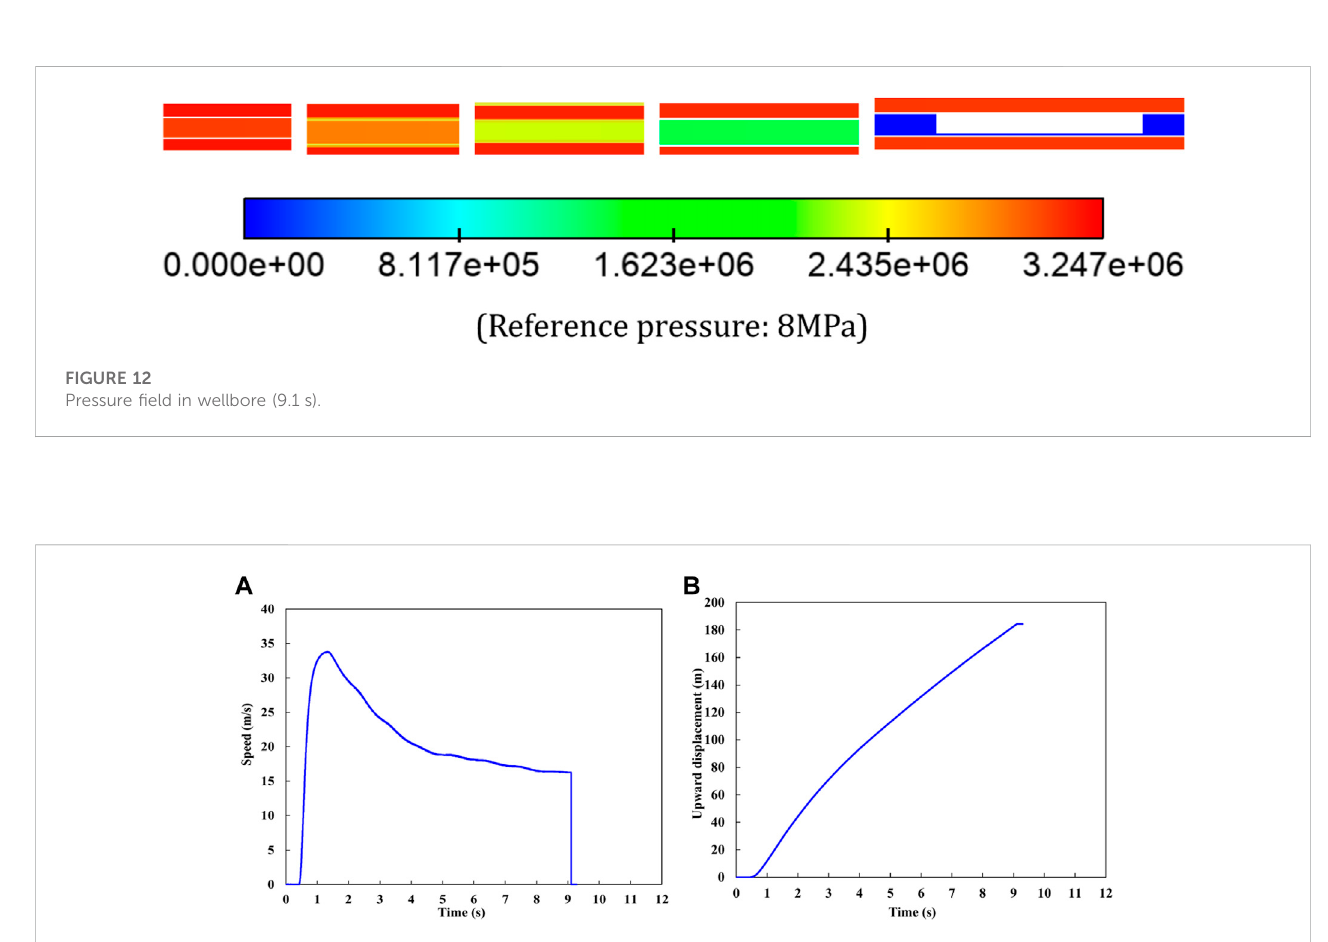
FIGURE 13 Plunger speed and displacement curves. (A) . Plunger speed (B) . Plunge